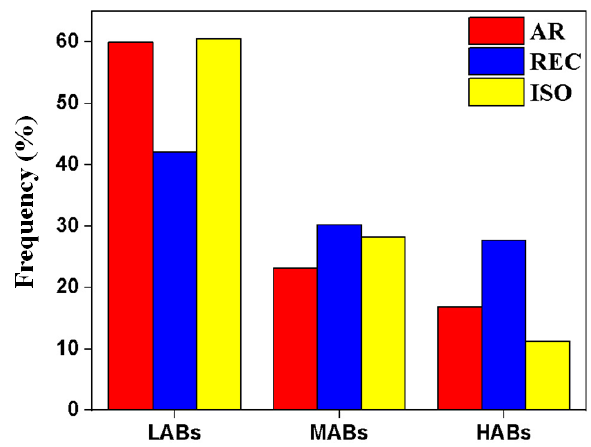
Figure 12. Types of grain boundaries presented in the EBSD analysis.